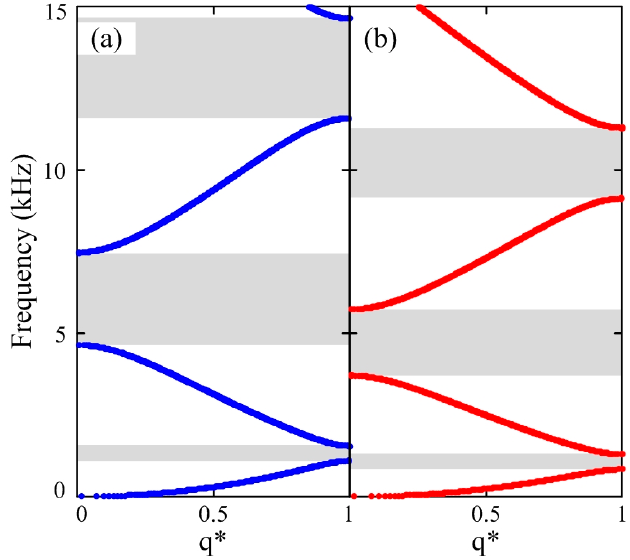
Figure 2. Band structure of the phononic crystal beam: ( a ) without coupling with water; ( b ) coupling with water (color online).